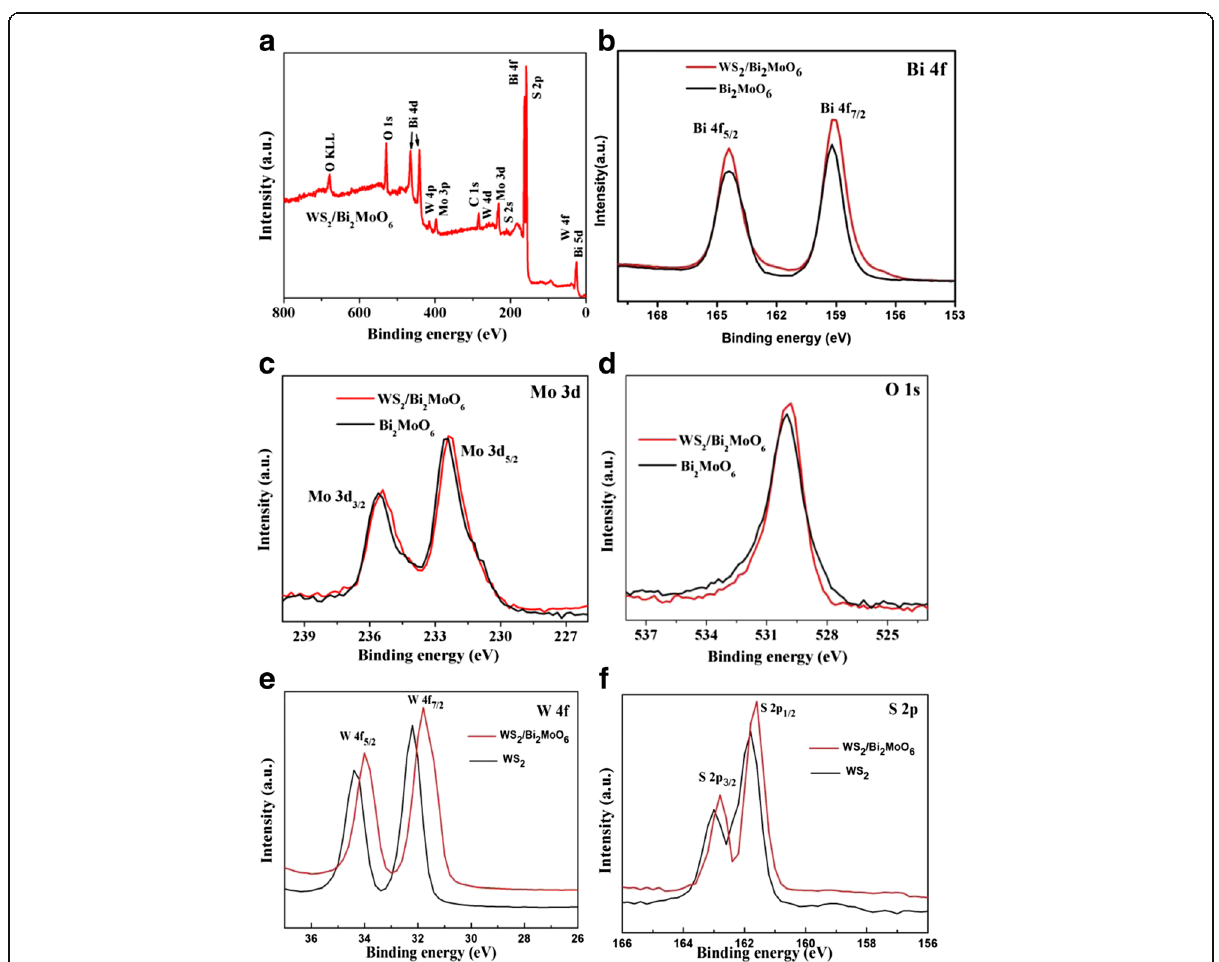
Fig. 4 Survey XPS spectra of the WS 2 /Bi 2 MoO 6 composite ( a ) and the high-resolution XPS spectra of Bi 4f ( b ), Mo 3d ( c ), O 1 s ( d ), W 4f ( e ), and S 2p ( f ) from Bi 2 MoO 6 , WS 2 , and the WS 2 /Bi 2 MoO 6 composite (5